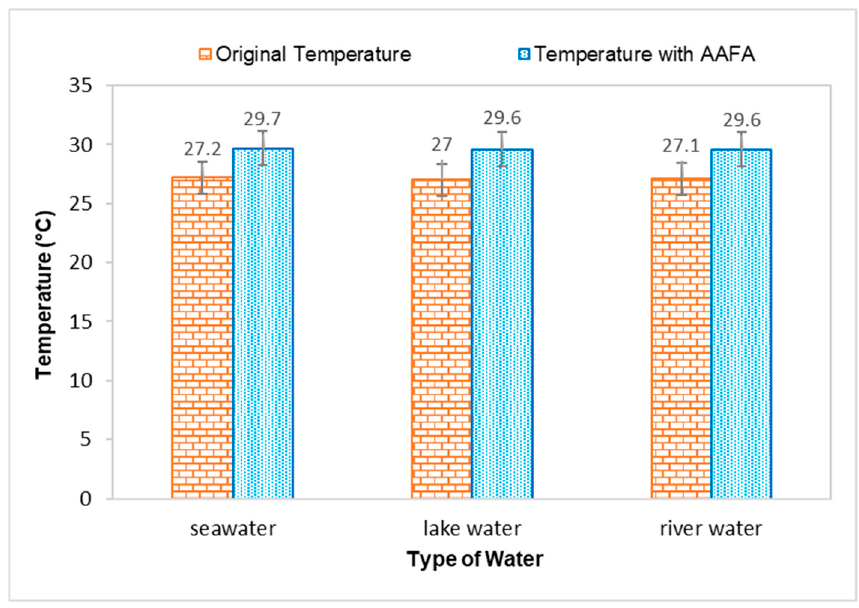
Figure 3. Effect on temperature when casting the AAFA in water.